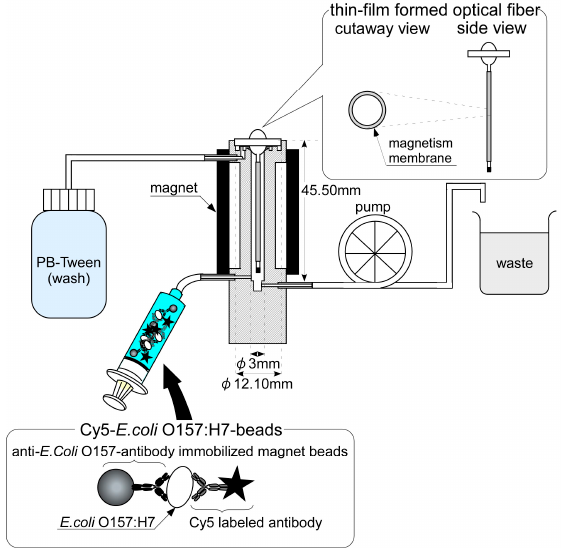
Figure 2. Pattern diagrams of the magnetic bead attach/release immunoassay system